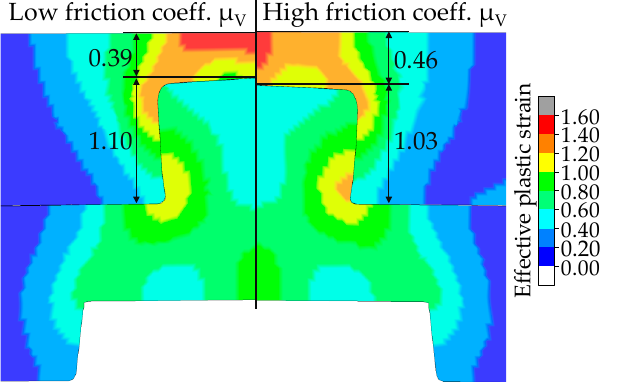
Figure 9. The comparison of a low and high friction coefficient µ V (c.f. Table 1) between the upper upsetting tool and aluminium joining partner.